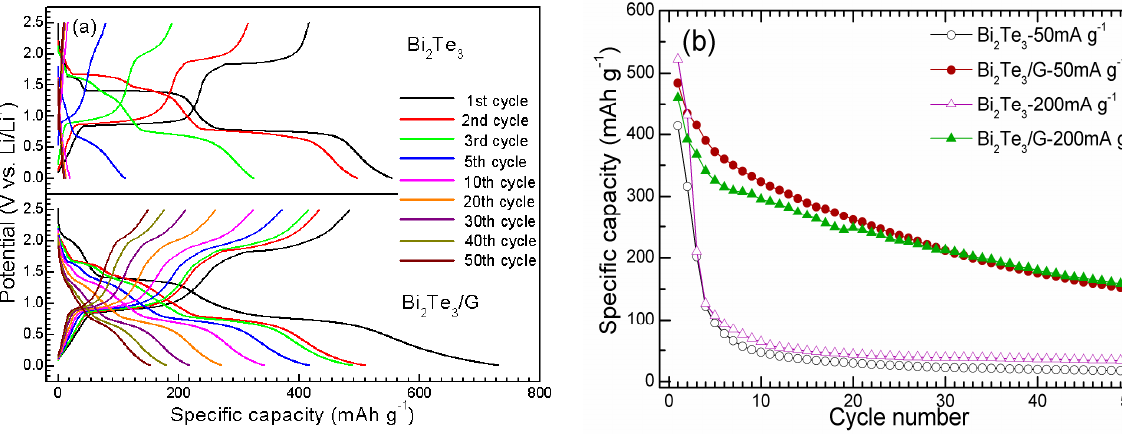
Te /G and Bi Te 2 3 2 3